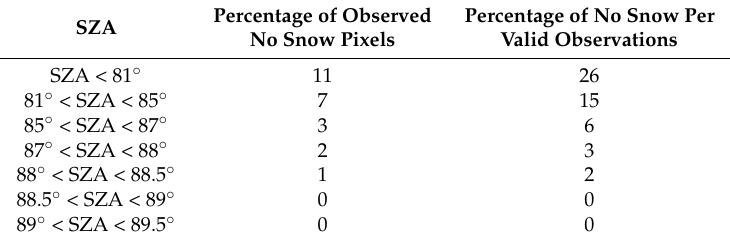
Table 7. Percentages of observed no snow pixels and no snow/snow ratios of the SZA classes used in the